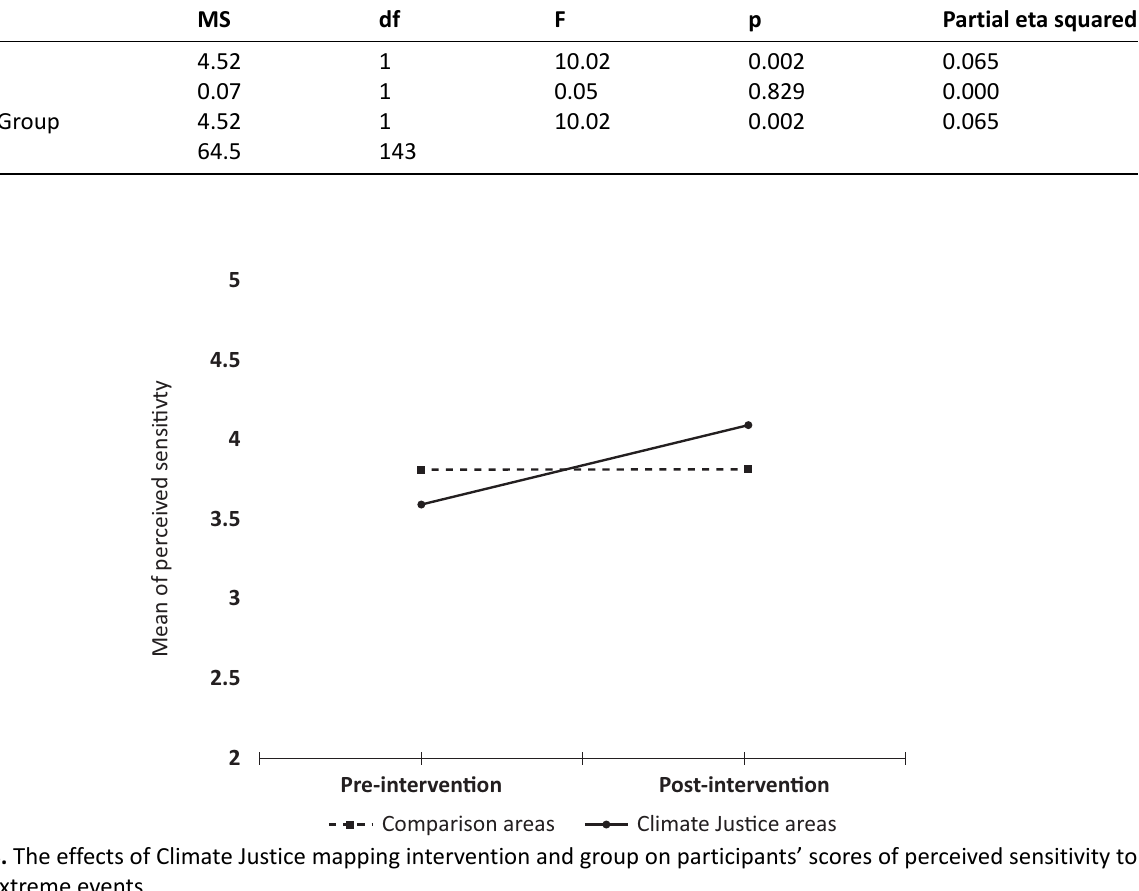
Table 5. Repeated measures mixed ANOVA analysis on participants’ ratings of perceived sensitivity.